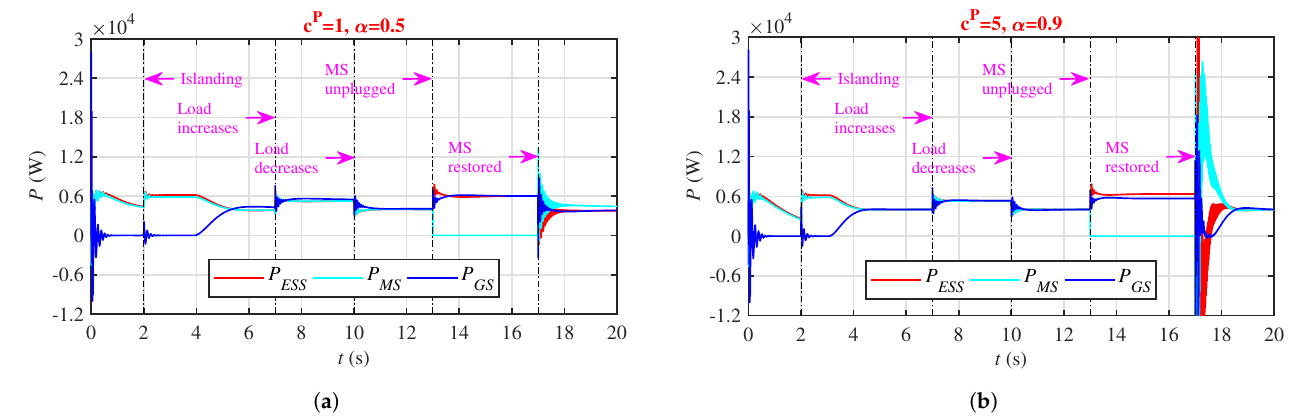
Figure 14. Power sharing outputs of DG units under different gain parameters.